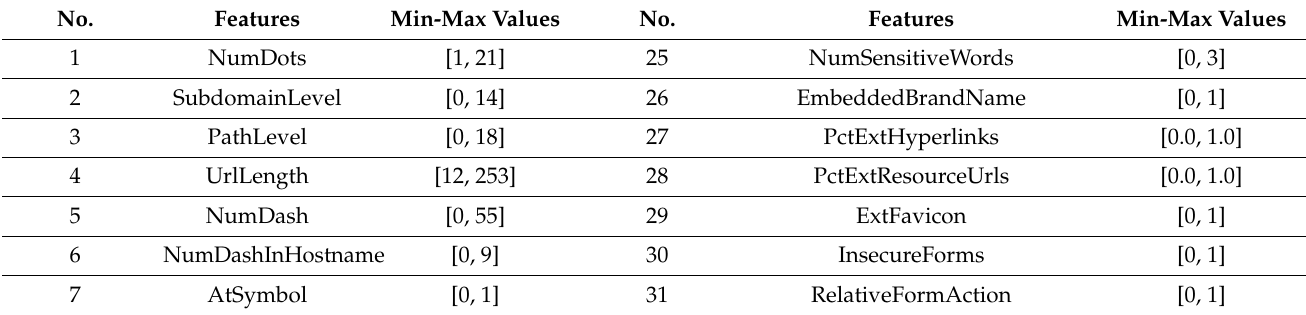
Table 6. Features of